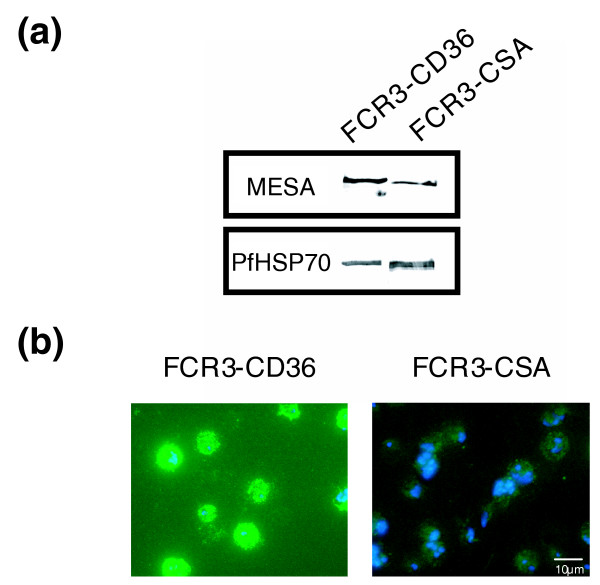
MESA overexpression in CD36 parasites. (a) Western blot of non-synchronized parasites from FCR3-CD36 and FCR3-CSA parasites. PfHsp70 protein is included as a loading control. A monoclonal antibody (Pf12.8B7.4) against MESA [60] detects approximately 2-4 times more protein in CD36 compared with CSA panned parasites. (b) Immunofluorescence for MESA protein in FCR3-CD36 and FCR3-CSA parasites. The 488-labeled secondary shows that MESA is considerably more abundant in CD36-compared with CSA-panned parasites. The intracellular distribution of MESA is the same in both parasite populations - with most labeling localizing to the periphery of infected erythrocytes.